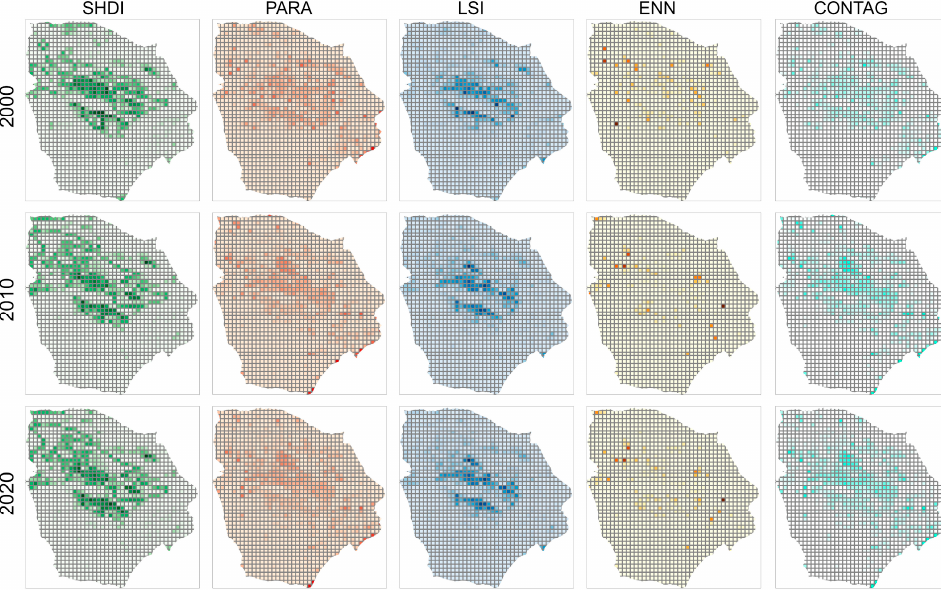
Figure 5. Spatial pattern of landscape metrics in the 10 km grid. SHDI, PARA, LSI, ENN and CONTAG are the Shannon diversity index, perimeter area ratio, landscape shape index, Euclidean nearest neighbor and contagion, respectively.